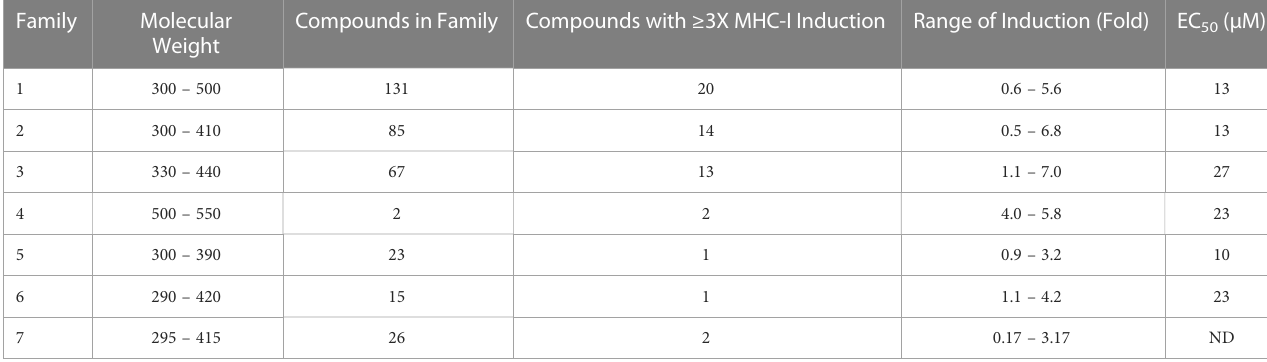
TABLE 3 MHC-1 induction in COLO-205 cells by synthetic cannabinoids. Family Molecular Compounds in Weight